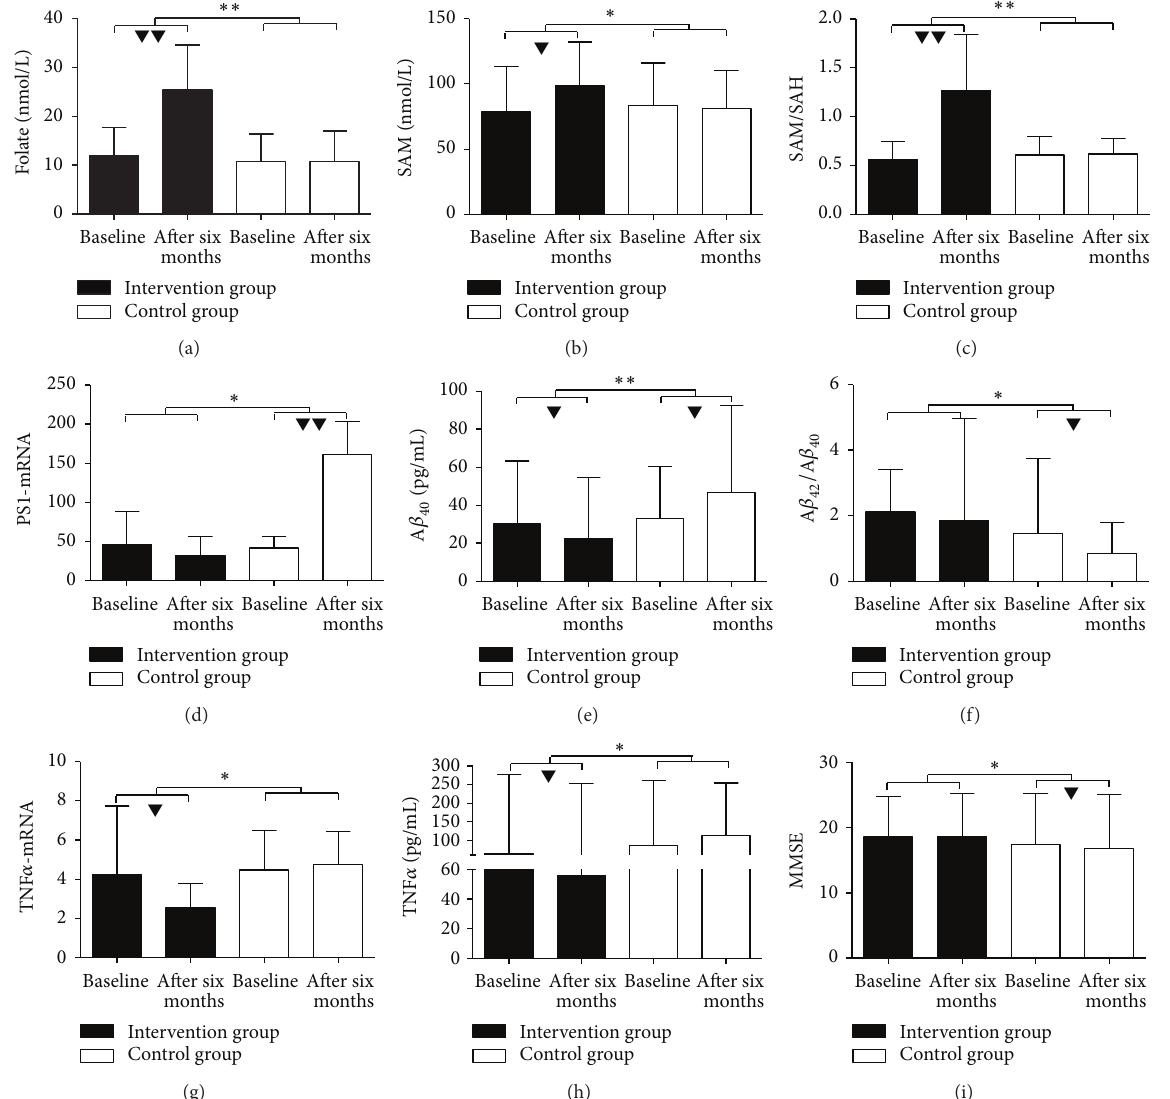
Figure 2: Changes in peripheral biochemical factors (folate, SAM, SAM/SAH, TNF 𝛼 -mRNA, TNF 𝛼 , PS1-mRNA, A 𝛽 40 , and A 𝛽 42 /A 𝛽 40 ) and MMSE at baseline and 6 months, in the intervention and control groups. Results are given as mean ± SD or median with interquartile range. Figures indicate a significant difference from the baseline to six months, between intervention group and control group by analysis of repeated-measures ANOVA ( 󳶃,∗ 𝑃 < 0.05 ; 󳶃󳶃,∗∗ 𝑃 < 0.01